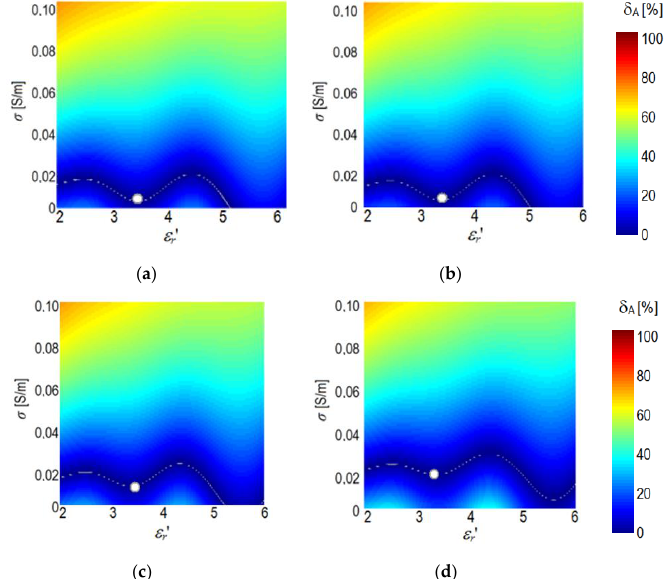
Figure 10. Relative error between numerical and analytical values of transmission coefficient (single-layer wall made of bricks B18) for: ( a ) σ FDTD = 0.01 S / m, ( b ) σ FDTD = 0.02 S / m, ( c ) σ FDTD = 0.03 S / m, ( d ) σ FDTD = 0.04 S / m.